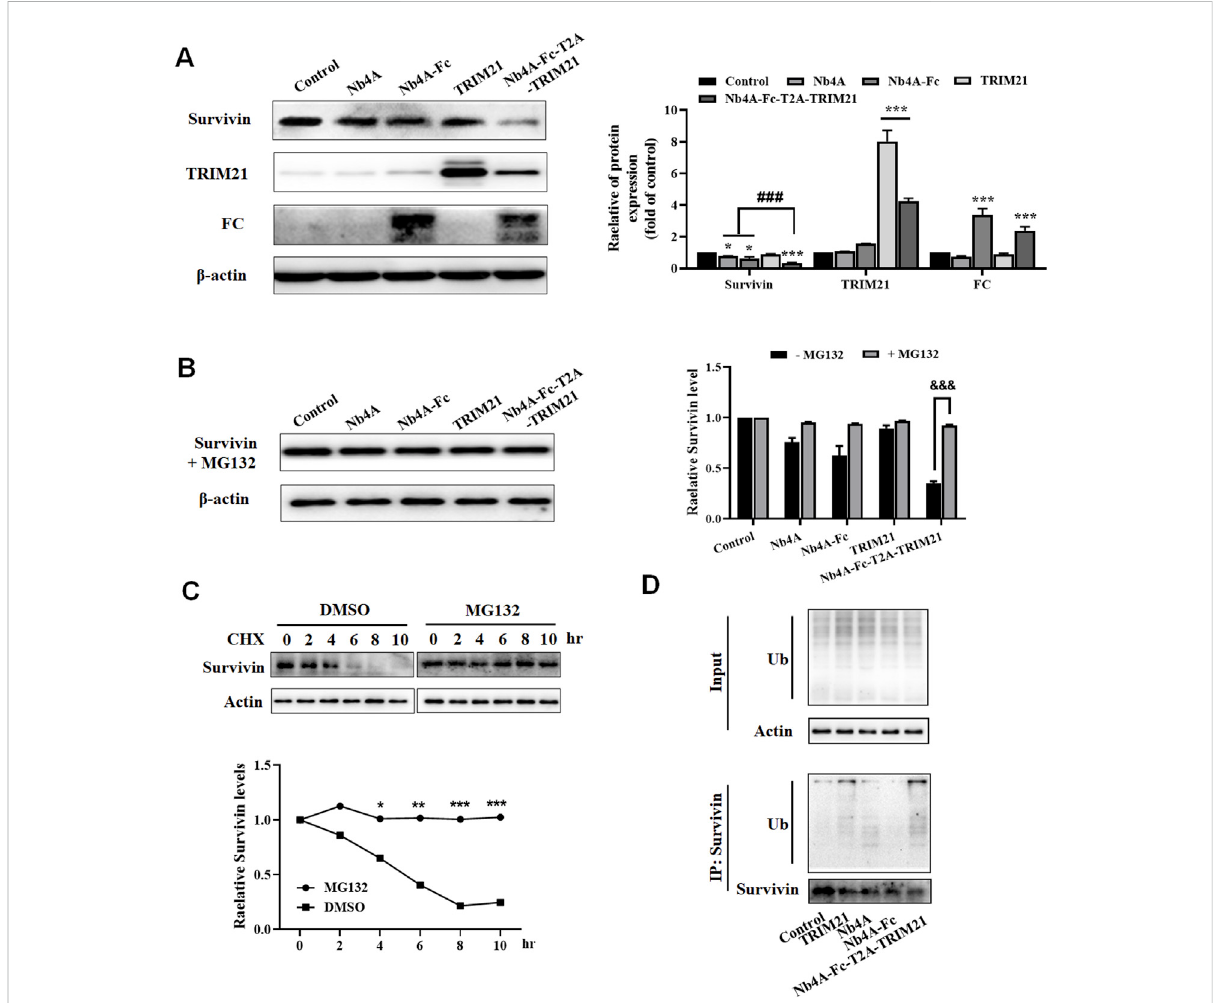
FIGURE 2 Nb4A-Fc-T2A-TRIM21 promotes the degradation of endogenous survivin. (A) MCF-7 cells were transfected with the recombinant plasmids pcDNA3.1(+), pcDNA3.1(+)-Nb4A, pcDNA3.1(+)-Nb4A-Fc, pcDNA3.1(+)-TRIM21, and pcDNA3.1(+)-Nb4A-Fc-T2A-TRIM21 for 48 h. The protein bands of survivin, TRIM21, and FC were normalized to β -actin, and the results are shown right ( n = 3). (B) Protein band of survivin + MG132 was normalized to β -actin, and the results are shown right ( n = 3). (C) MCF-7 cells were treated with CHX (100 μ g/ml) for the indicated time, with or without MG132, and then subjected to Western blotting analysis of survivin, and the results are shown below ( n = 3). (D) Ubiquitination assays were performed as described in Materials and Methods. Immunoprecipitation was separated via SDS-PAGE, and the conjugates were detected with anti- ubiquitin and anti-survivin antibodies. * p < 0.05, ** p < 0.01, and *** p < 0.001 versus control, ### p < 0.001 versus the Nb4A-Fc-T2A-TRIM21 group, and &&& p < 0.001 versus the survivin + MG132 group. Data are expressed as mean ±